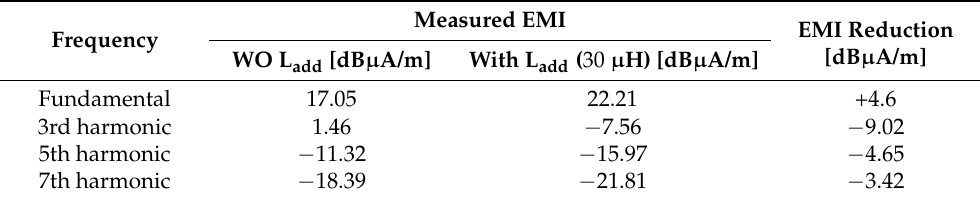
Figure 26. Equipment setup for measuring the EMI of the WPT system. Table 15. Comparison of EMI results for WPT systems with and without series inductors (30 μH ).